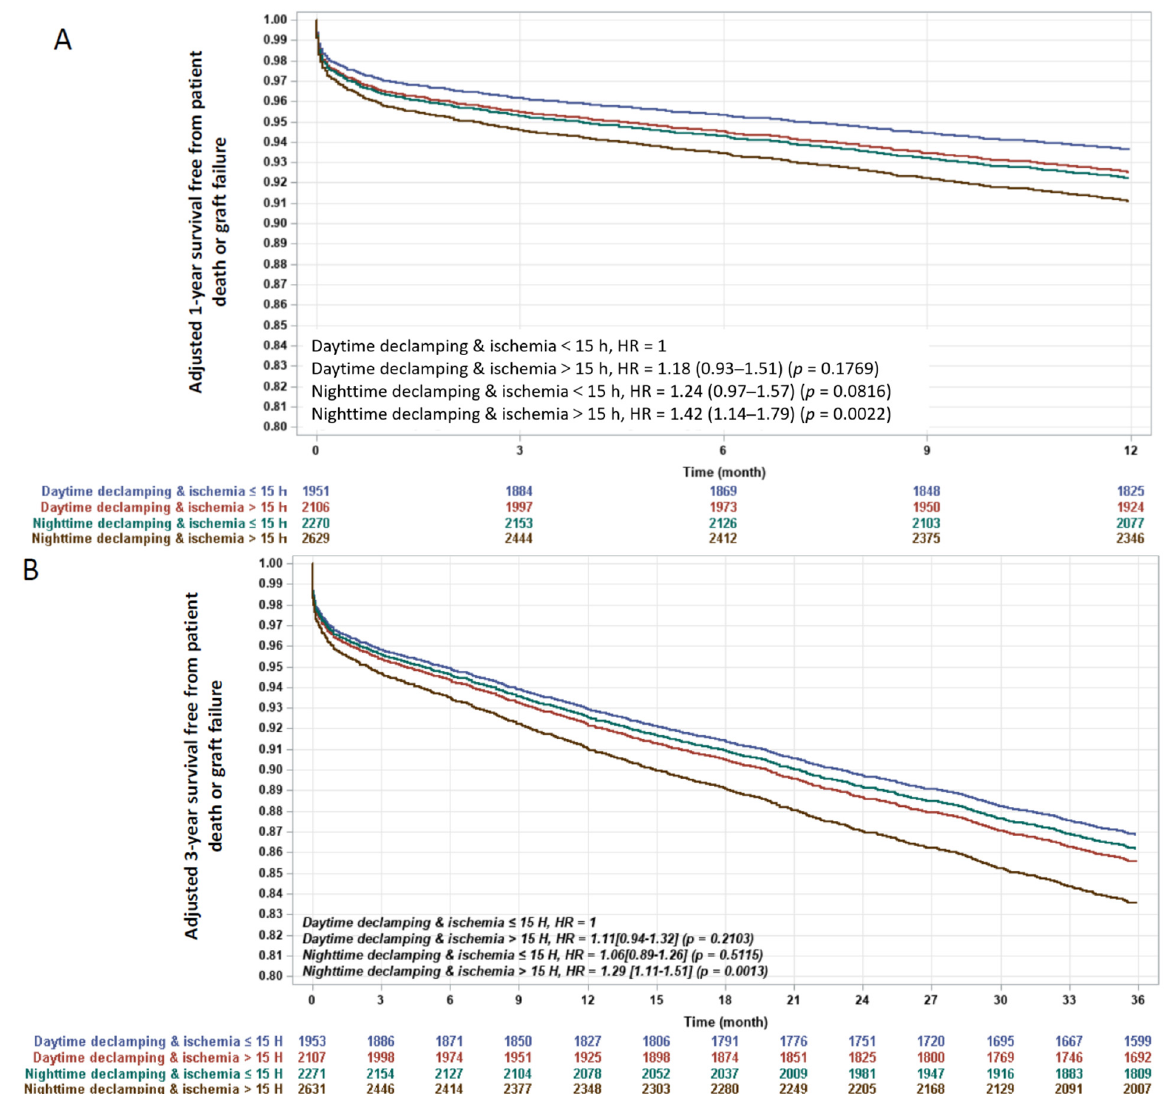
Figure 4. Adjusted 1- ( A ) and 3-year ( B ) survival curves according to ischemia duration and declamping time-of-the-day. p -value and Hazard Ratio [95%CI] by multivariate Cox-model. Day-time declamping and ischemia <15 h in blue (ischemia duration = 12.3 ± 2.2 h); day-time declamping and ischemia >15 h in red (ischemia duration = 22.2 ± 5.6 h); night-time declamping and ischemia <15 h in green (ischemia duration = 12.2 ± 2.3 h); night-time declamping and ischemia >15 h in black (ischemia duration = 20.2 ± 4.0 h).